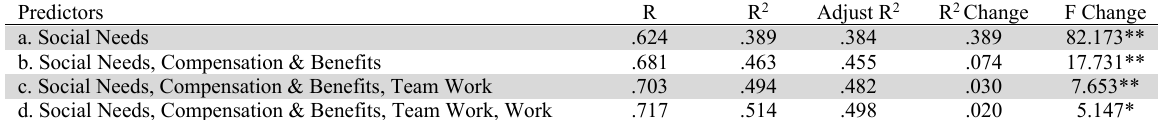
Model summary stepwise multiple regression analysis for work-life balance aspects of social needs, time management, team work, compensation & benefits and work with personal needs